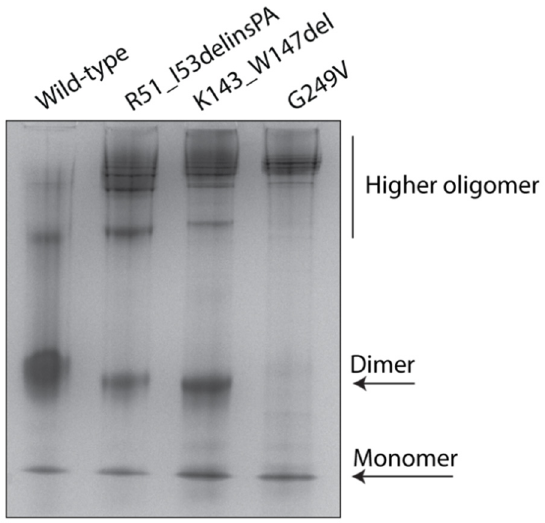
Figure 4. Oligomerization states of wild-type and mutant MBP–CHIP proteins. Native structures of 5 µg MBP–CHIP proteins were studied by native–PAGE on a 10% gel. Protein bands were visualized by Coomassie blue staining and analyzed by Fiji (ImageJ) software [15].